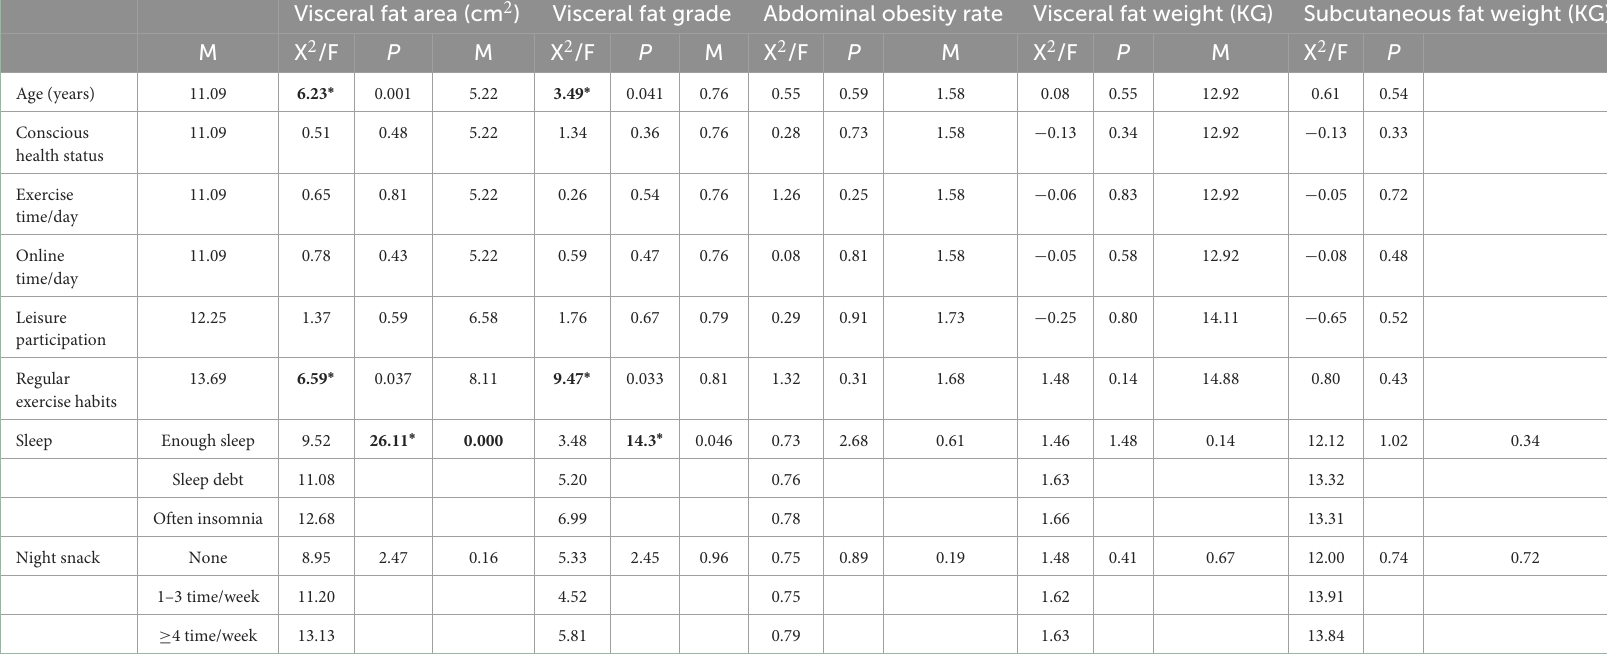
TABLE 5 Statistical table of the influence of College Students’ demographic variables on their abdominal obesity. Visceral fat area (cm 2 ) Visceral fat grade Abdominal obesity rate Visceral fat weight (KG) Subcutaneous fat weight